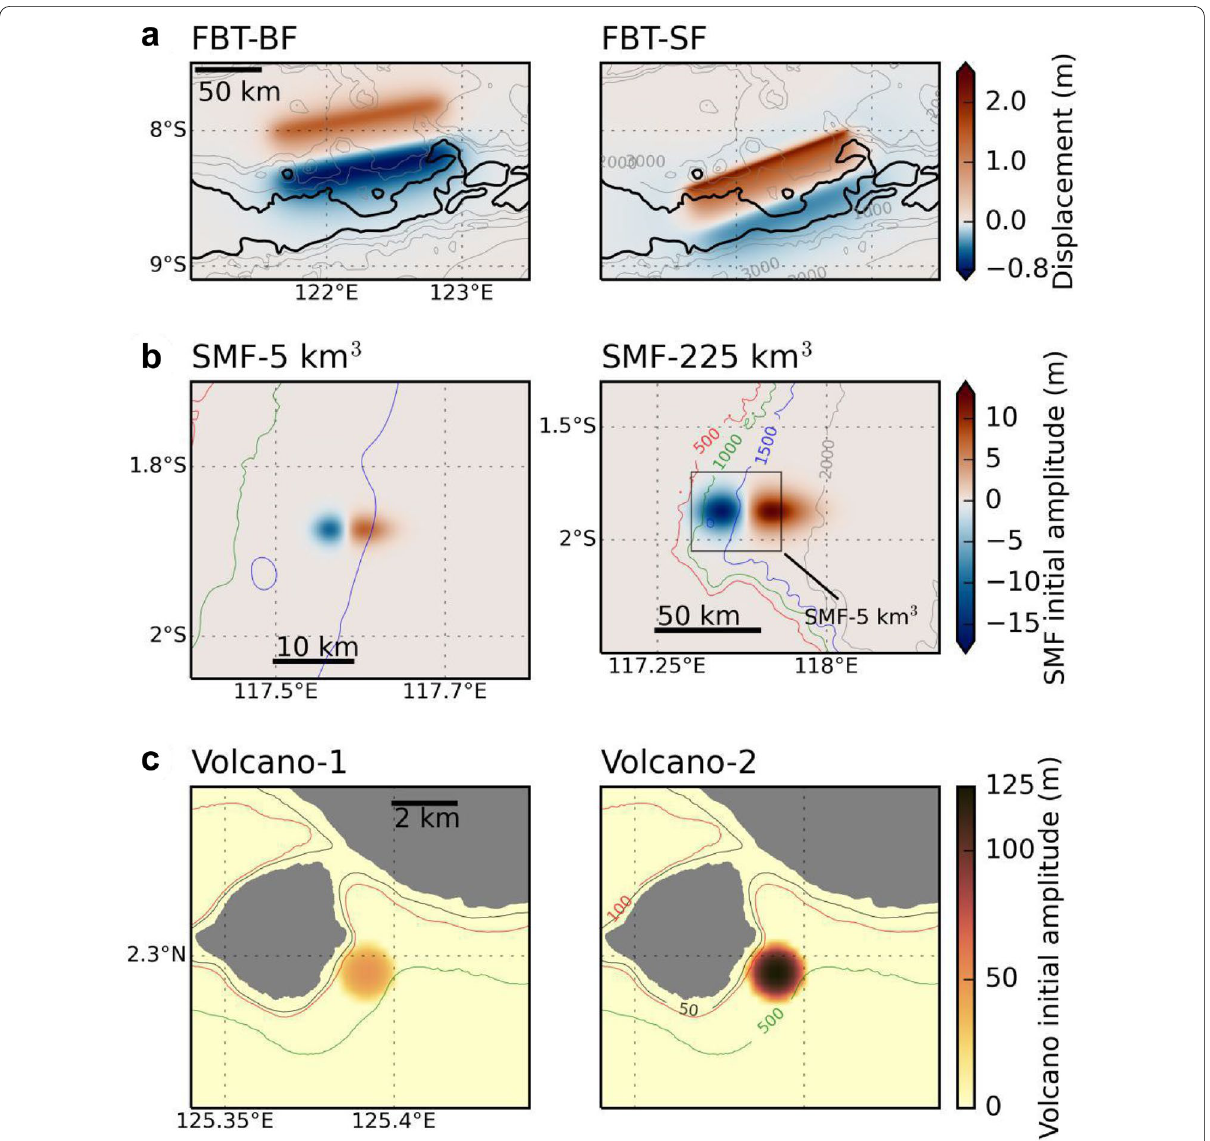
Fig. 2 Various tsunami source models used in this study for modelling tsunami scenarios. a Two earthquake scenarios for the Flores back-arc thrust basal fault (FBT-BT) and splay fault (FBT-SF). b Submarine mass failures (SMF) of volumes 5 km 3 and 225 km 3 ; black box shows location of SMF-5 km 3 c Two volcano flank-collapse scenarios with volume of 0.10 km 3 (Volcano-1) and 0.26 km 3 (Volcano-2). Contours represent bathymetry depth in